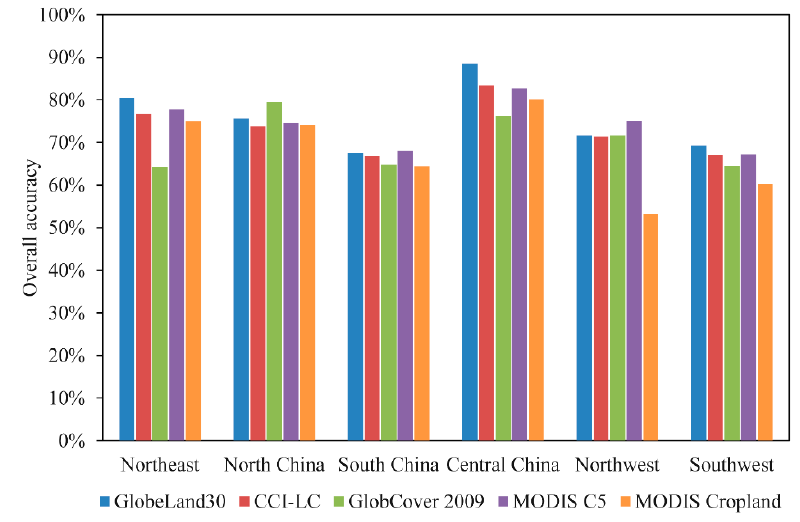
Figure 5. Accuracy assessment of the five input datasets in each region based on training samples.